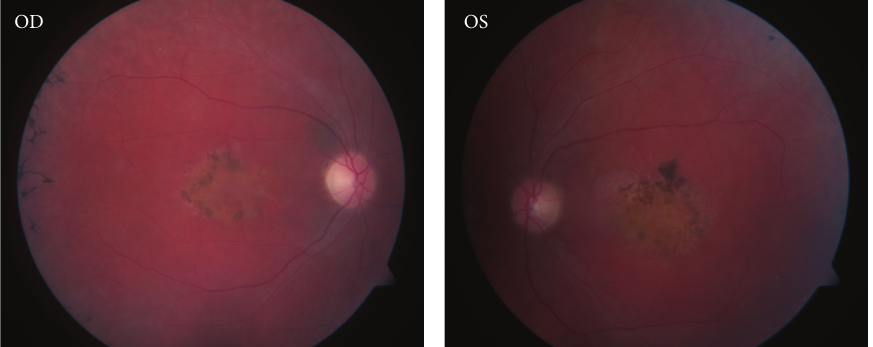
Figure 1: Fundus oculi examination of proband.